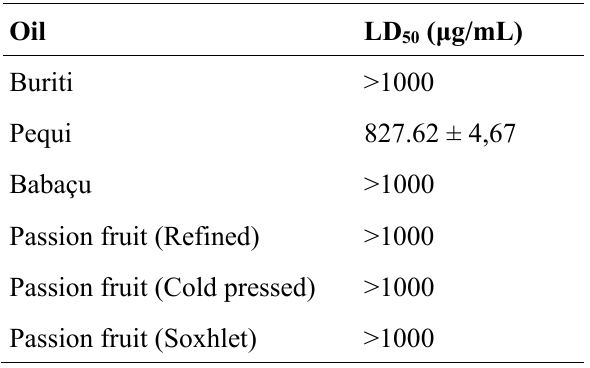
Table 7. Cytotoxic